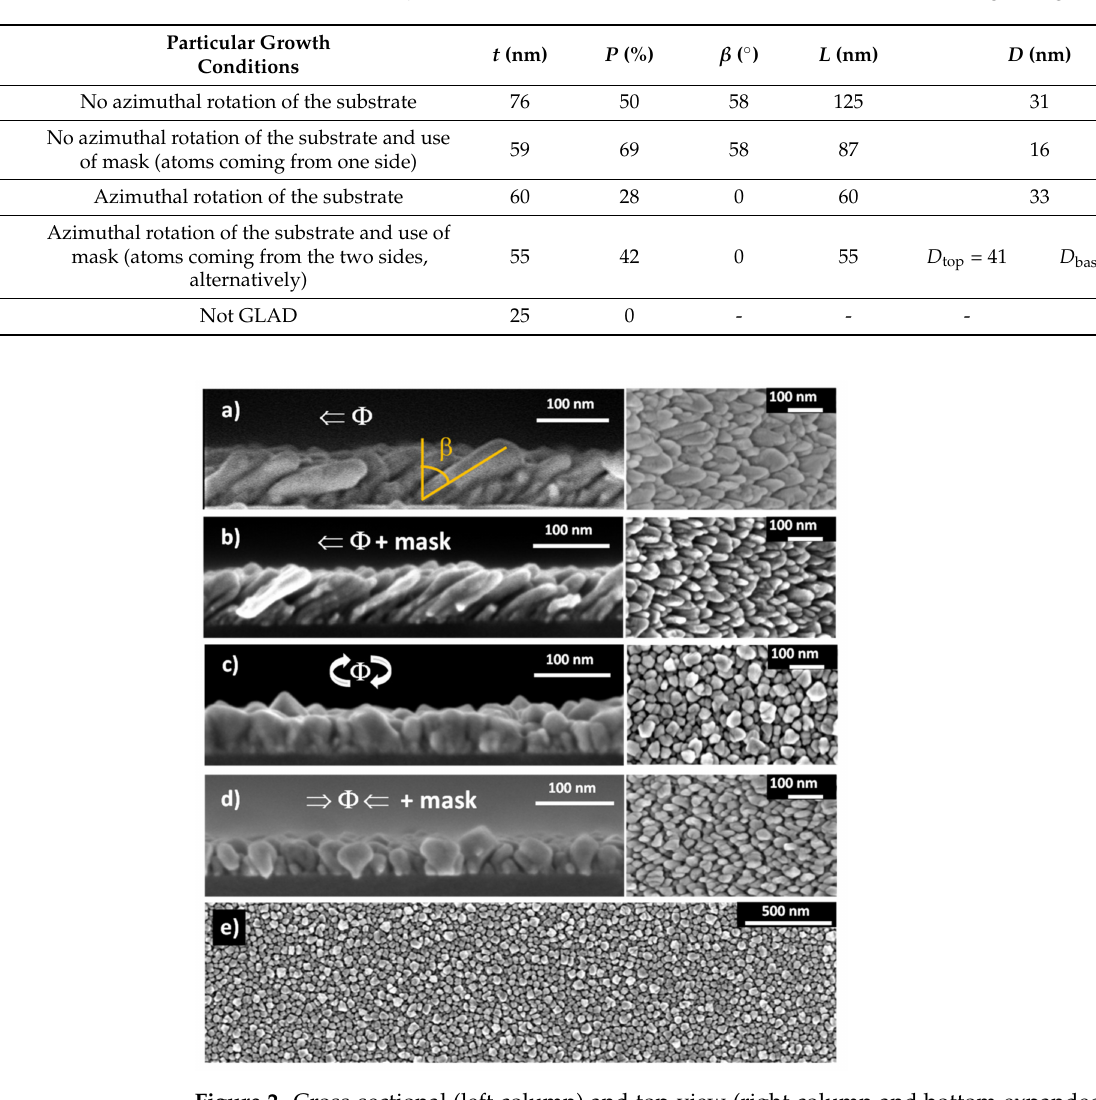
Table 1. Growth conditions and morphological parameters of Fe nanopillars (NPs) and thin film reference samples: Average values of film thicknesses ( t ), porosity ( P ), NP tilt angle ( β ), lengths ( L ) and diameters ( D ). t , β , L and D are measured from the cross-sectional SEM images (Figure 2a–d).